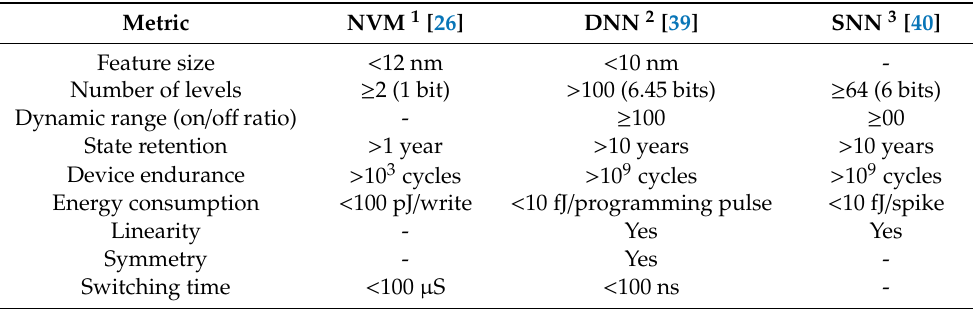
Table 1. Summary of desired performance metrics for